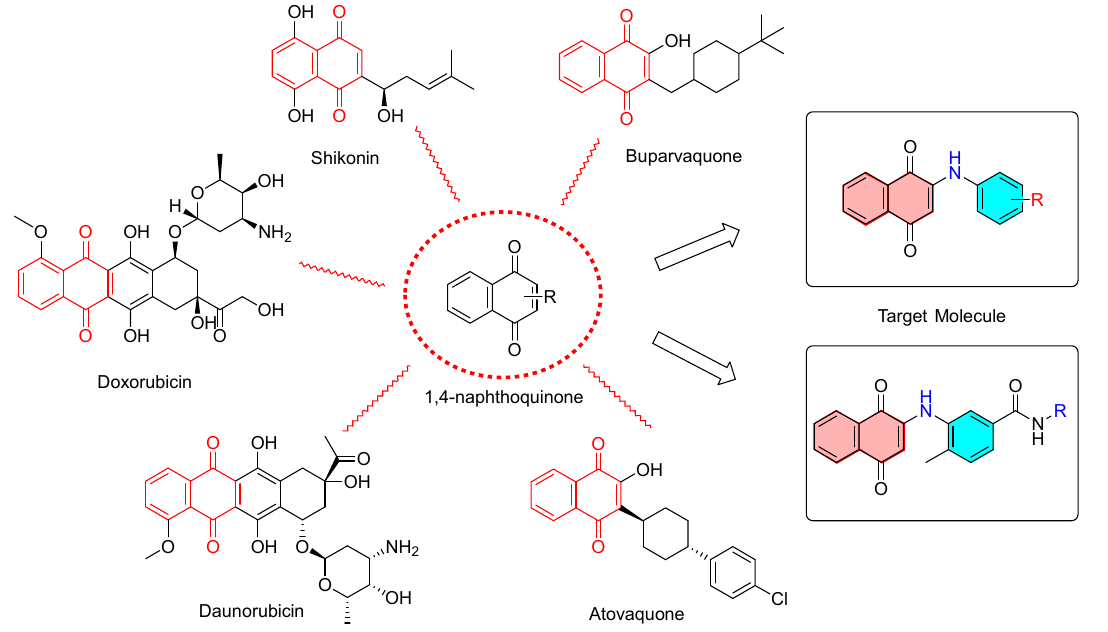
Figure 1. The chemical structures of representative 1,4-naphthoquinone anti-cancer drugs.